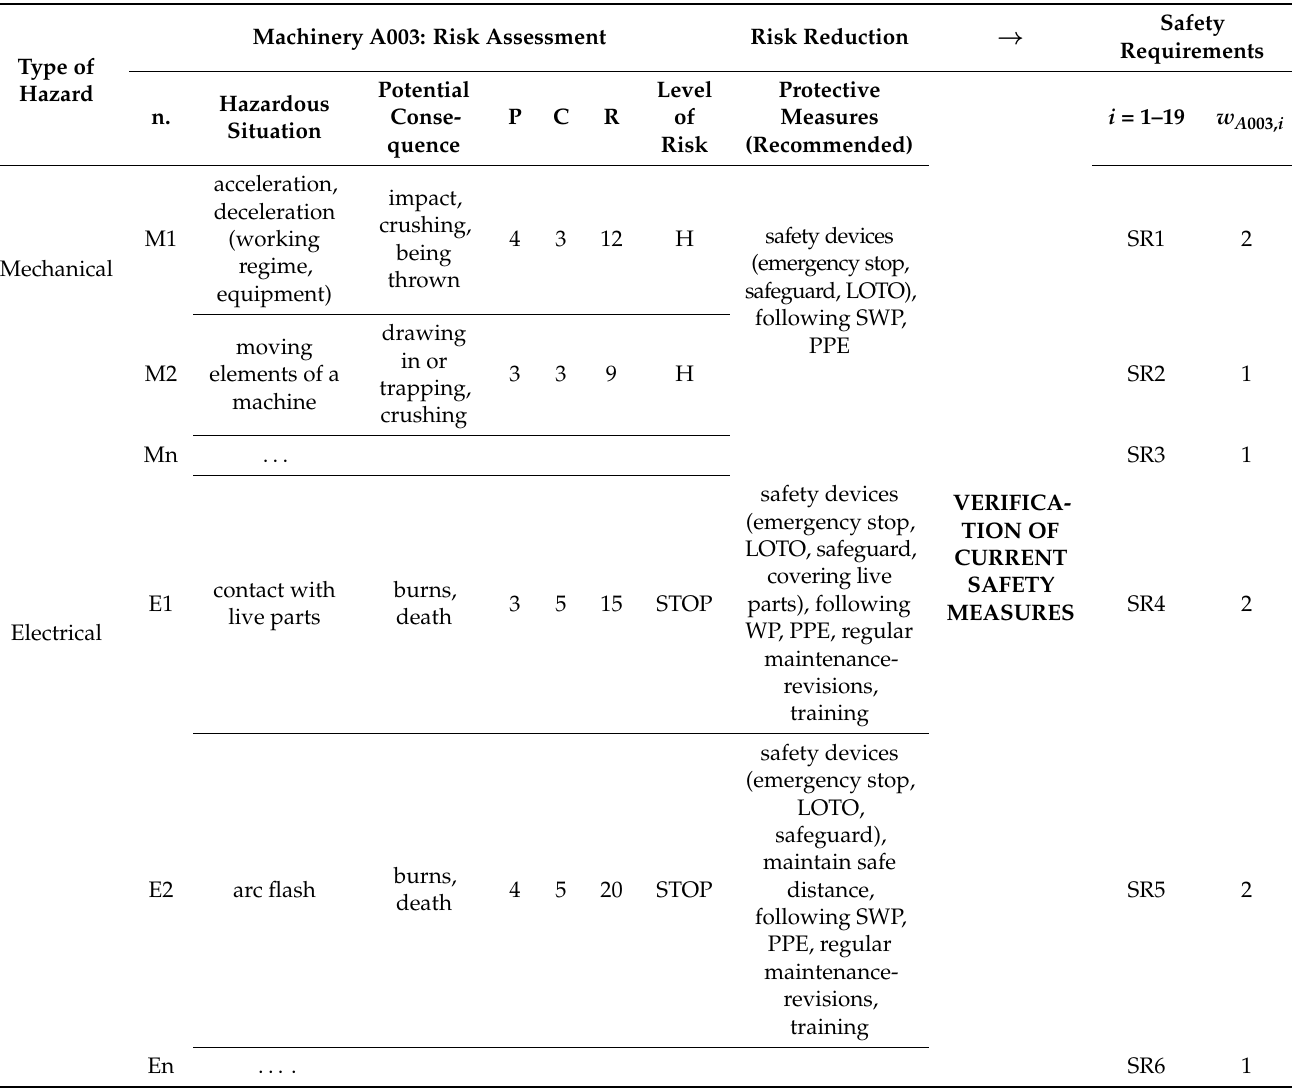
Table 3. Simplified process of the applied methodology of risk assessment and safety measures implementation evaluation on machine A003 (source: own design).